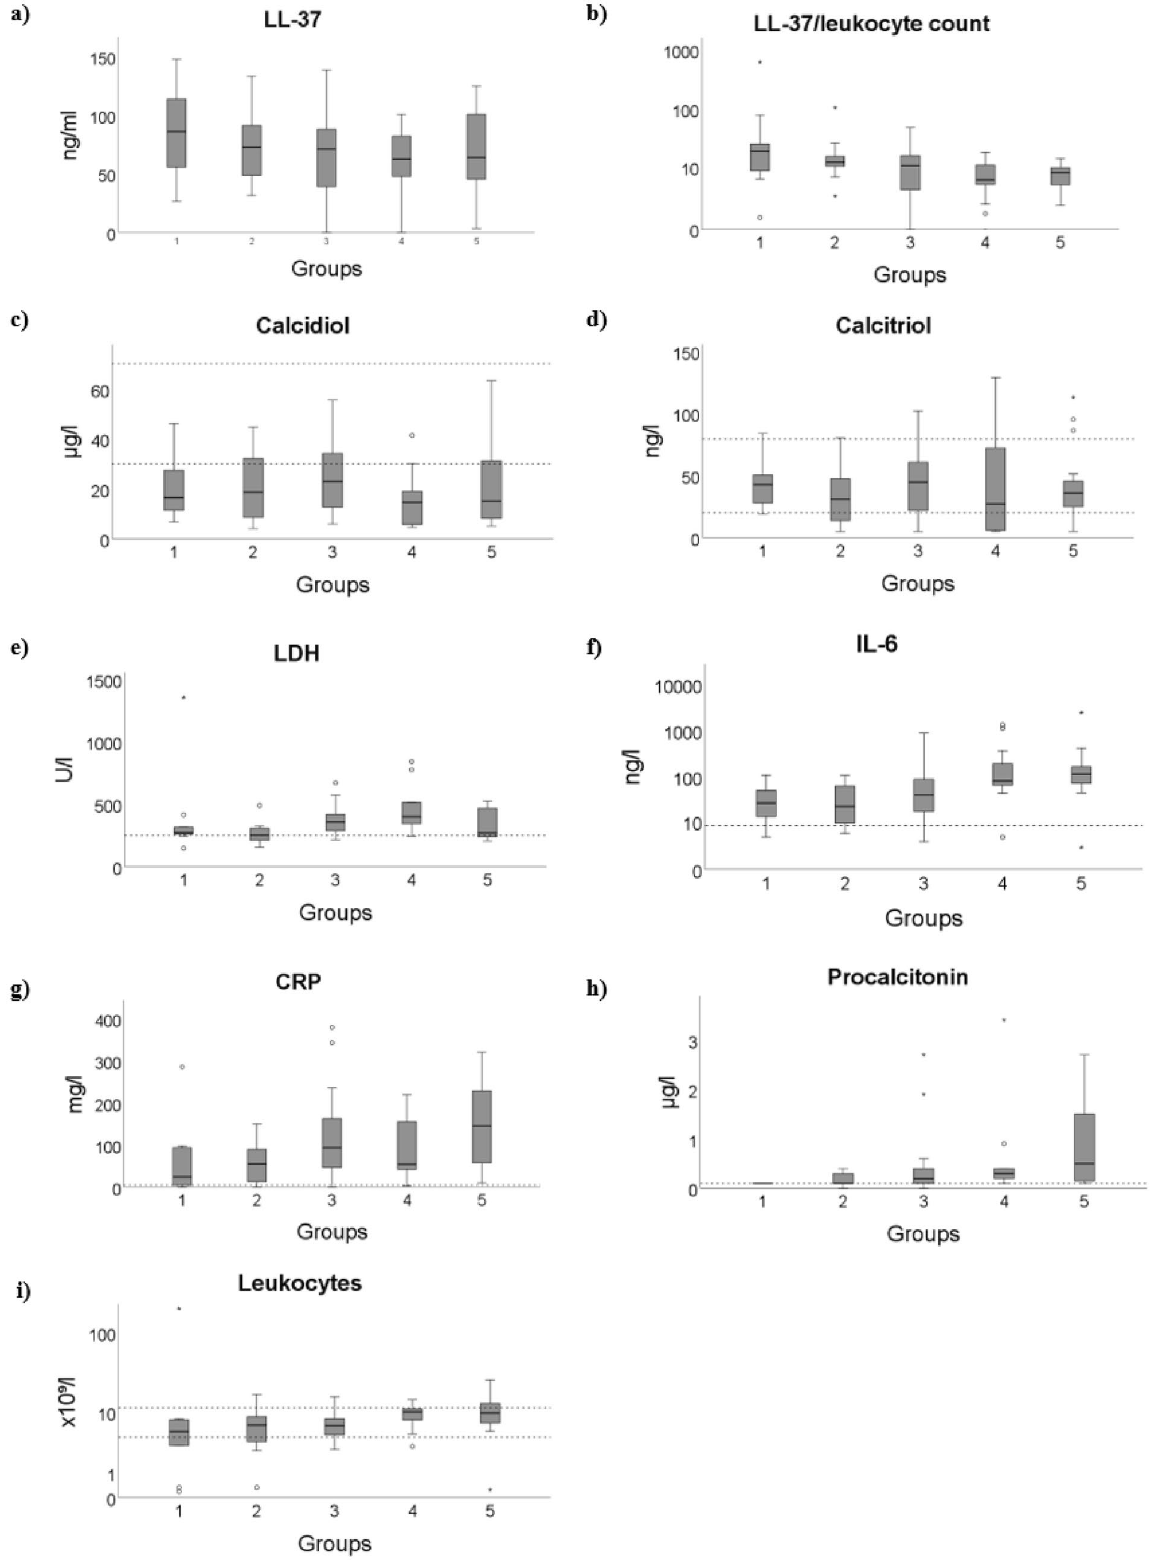
Figure 2. Boxplot of parameters significantly correlated with COVID-19 severity. The median, upper quartile, lower quartile, minimum and maximum are shown. The dashed lines show the reference values. The correlation coefficients and significances are shown in Table 2. Calidiol and calcitriol are not significantly correlated with COVID-19